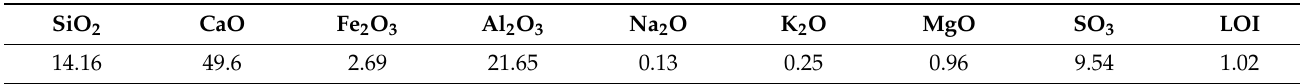
Table 1. Chemical composition of BCSA cement